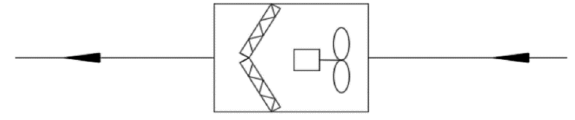
Figure 13. PM2.5 pollution control system opening and closing plan.